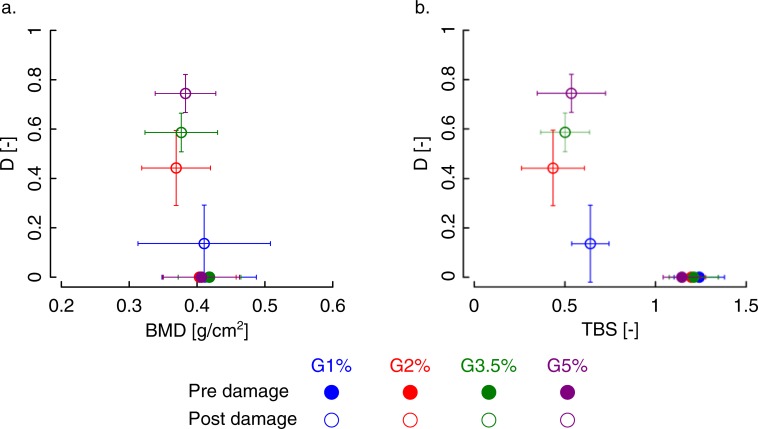
Comparison of accumulated damage obtained from different strain levels with a) BMD and, b)TBS.